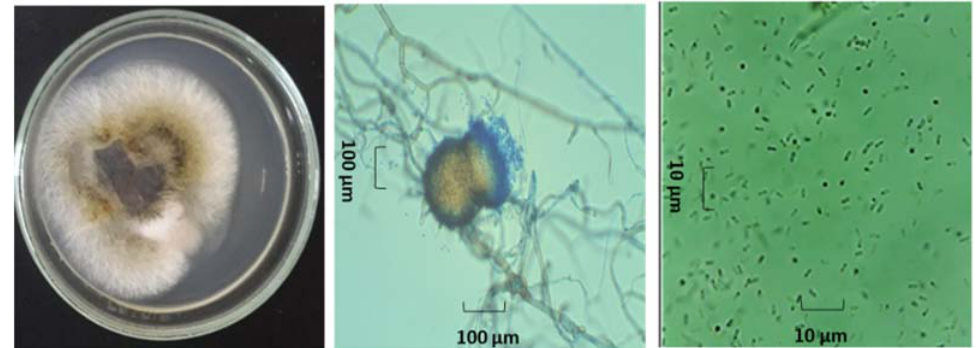
Figure 7. Morphological examination of the isolate Ech4. Colony on PDA ( left ), hyphae and conidiomata picnidial ( center ), and conidia ( right ).